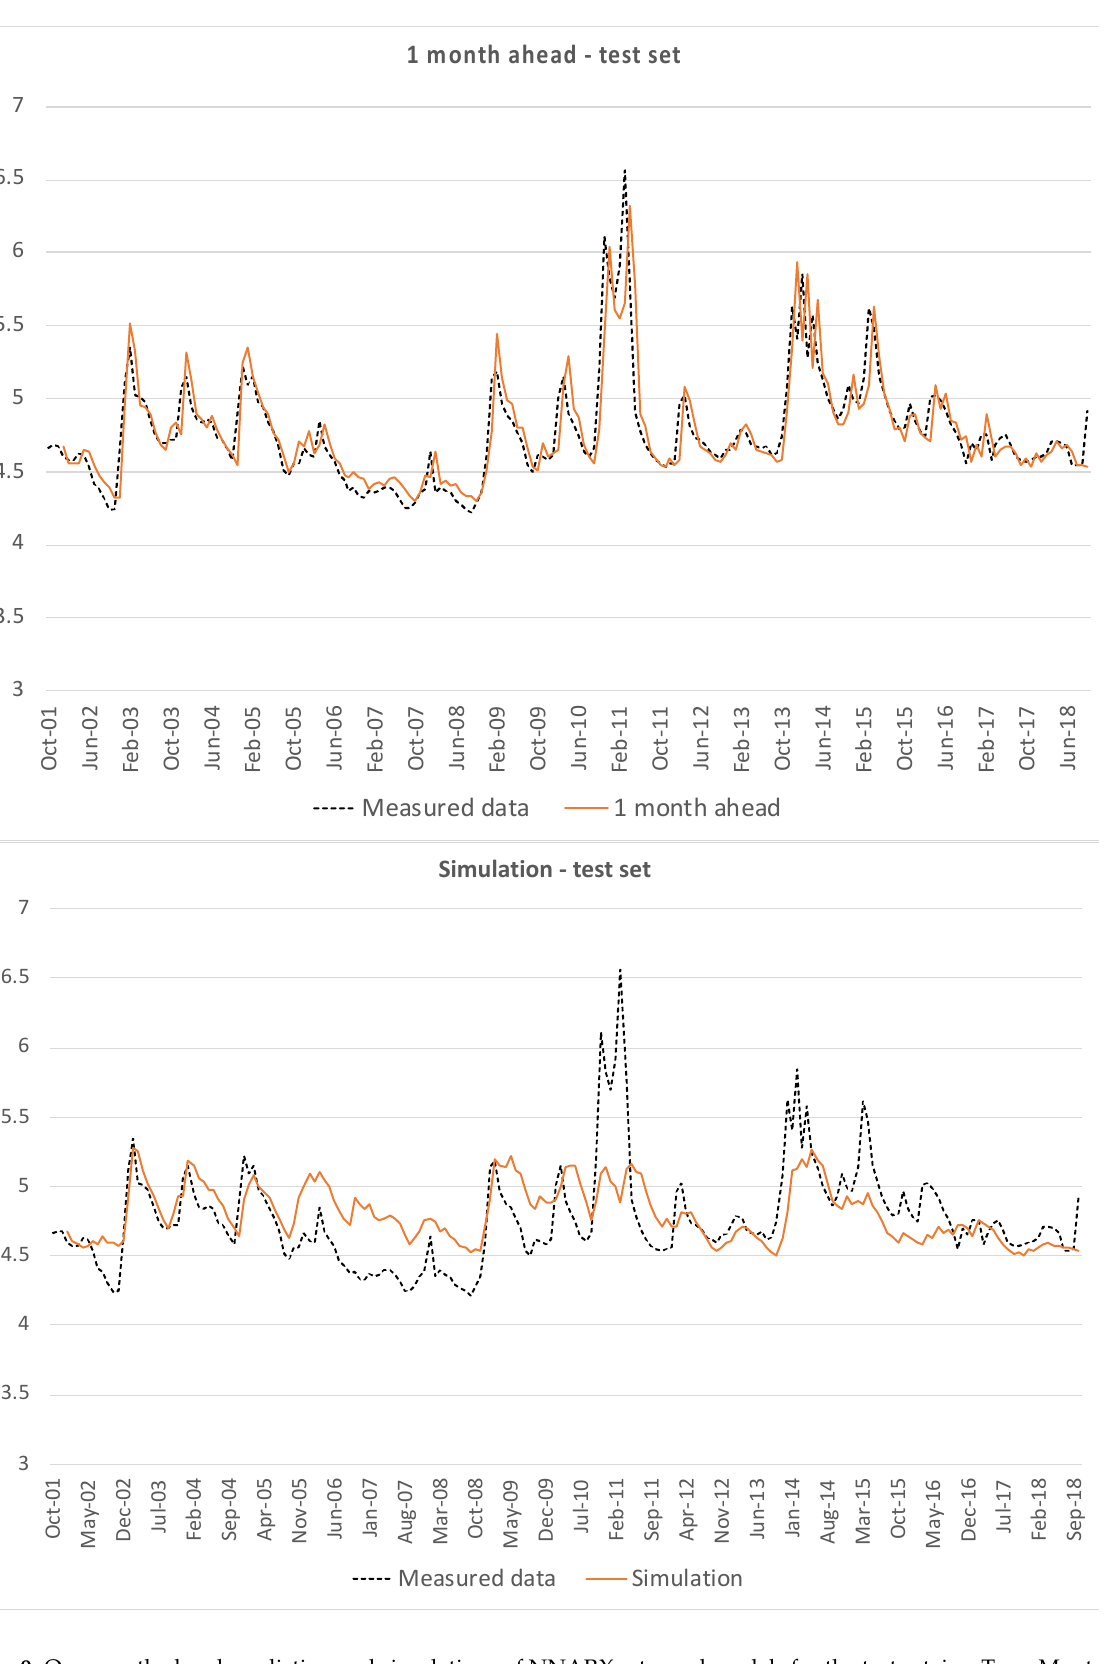
Figure 9. One month ahead prediction and simulations of NNARX returned models for the test set, i.e., Terra Montonata, piezometric levels on the vertical axis are in m a.s.l.